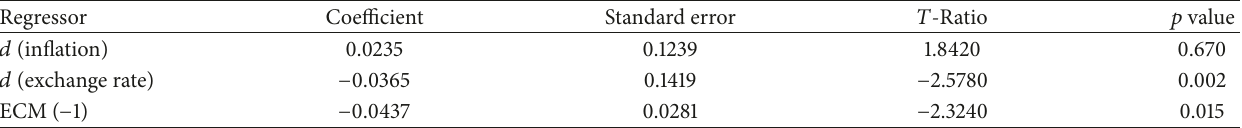
Table 5: Error correction representation of the selected ARDL model: ARDL (1, 1, 0) selected by Schwarz Bayesian Criterion.